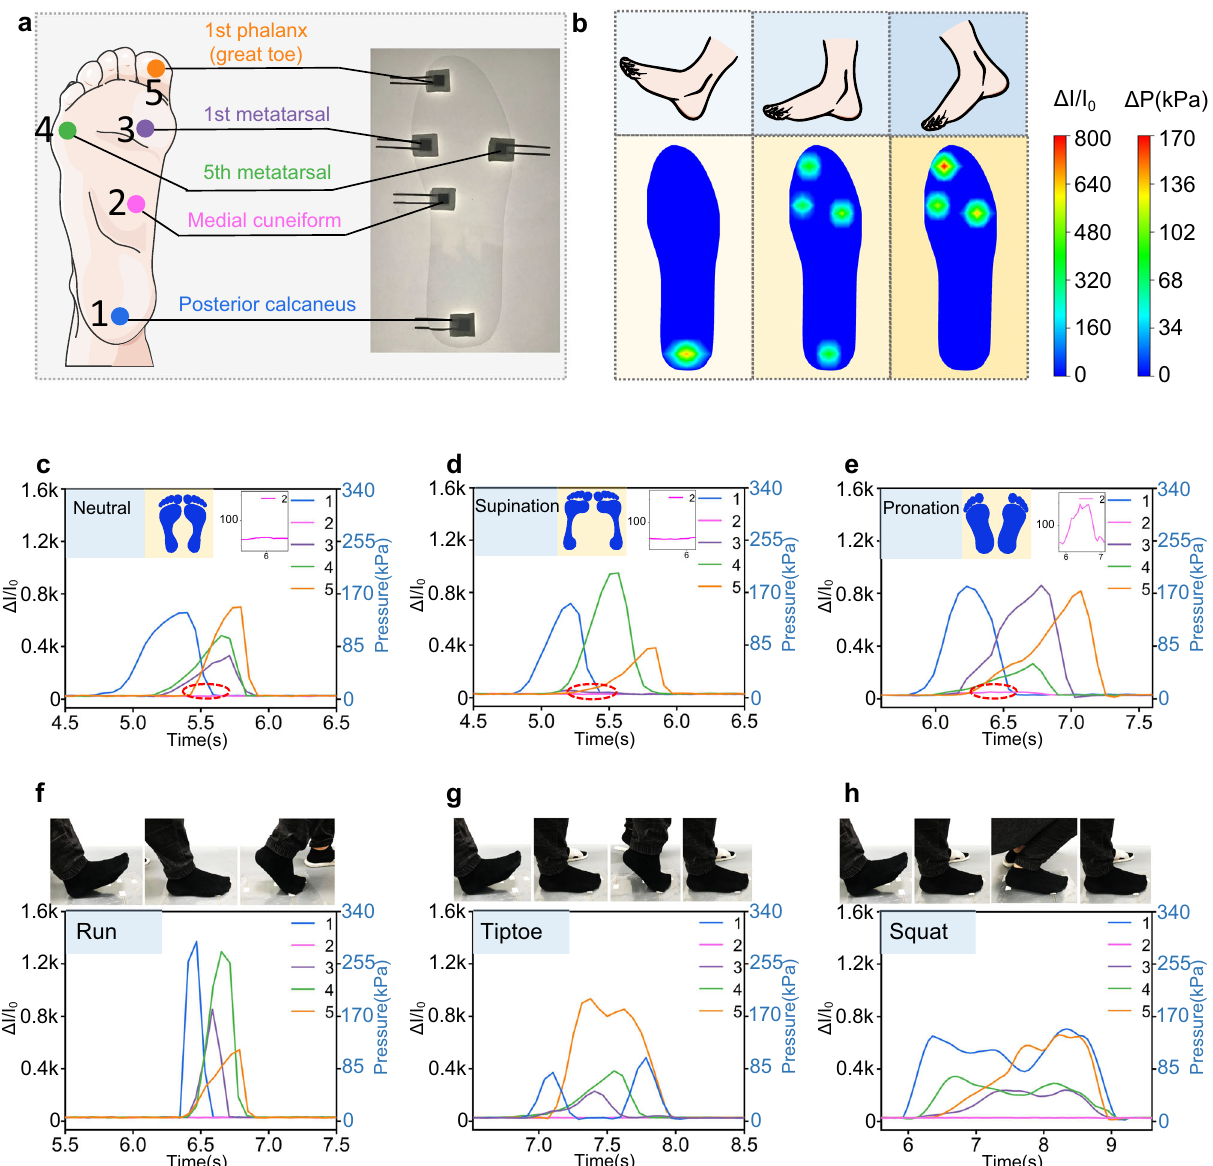
Fig. 6 Flexible smart insole composed with HPPS array for plantar pressure monitoring. a Optical image of HPPS array on smart insole and correspond anatomy in the schematic illustration of human foot. b Evolution of the pressure distribution mapping during dynamic waking process. Real-time recorded current variations and corresponding calculated pressure of the fi ve sensors to detect walking posture of three different people with ( c ) Neutral gait ( d ) Supination gait ( e ) Pronation gait, respectively. Real-time recorded current variations and corresponding calculated pressure of the fi ve sensors to recognize sports biomechanics of ( f ) Running ( g ) Standing on tiptoe ( h ) Squatting,